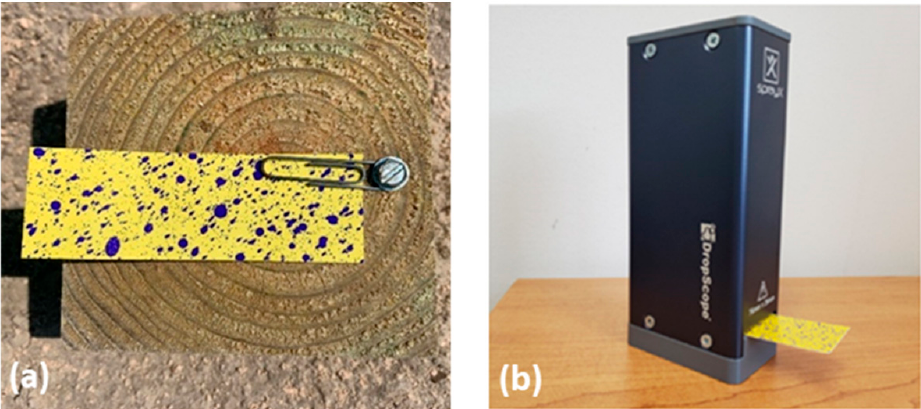
Figure 3. ( a ) Illustration of data collection setup (wooden block and water-sensitive paper) used in the field, and ( b ) the DropScope instrument used for analyzing water-sensitive paper.